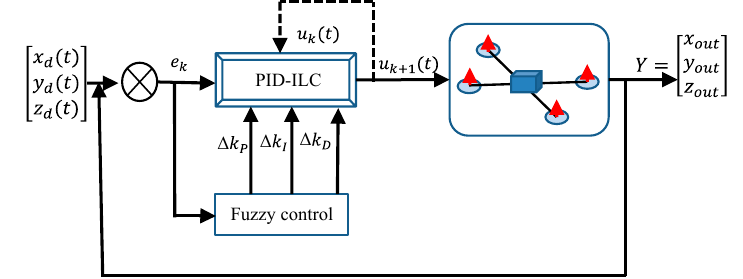
Figure 2. System architecture of the fuzzy PID-ILC for the quadrotor.